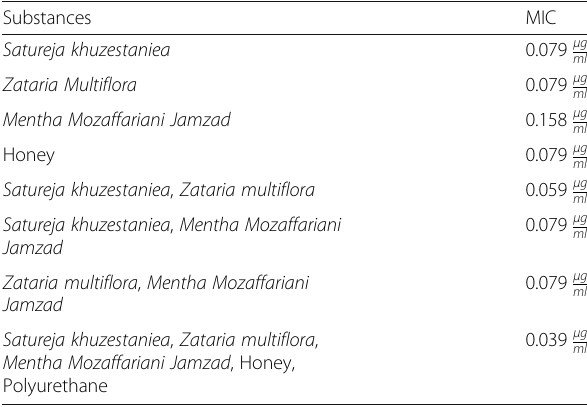
Table 2 MIC Results for ZOUSH Ointment compounds: active ingredients as single, dual,